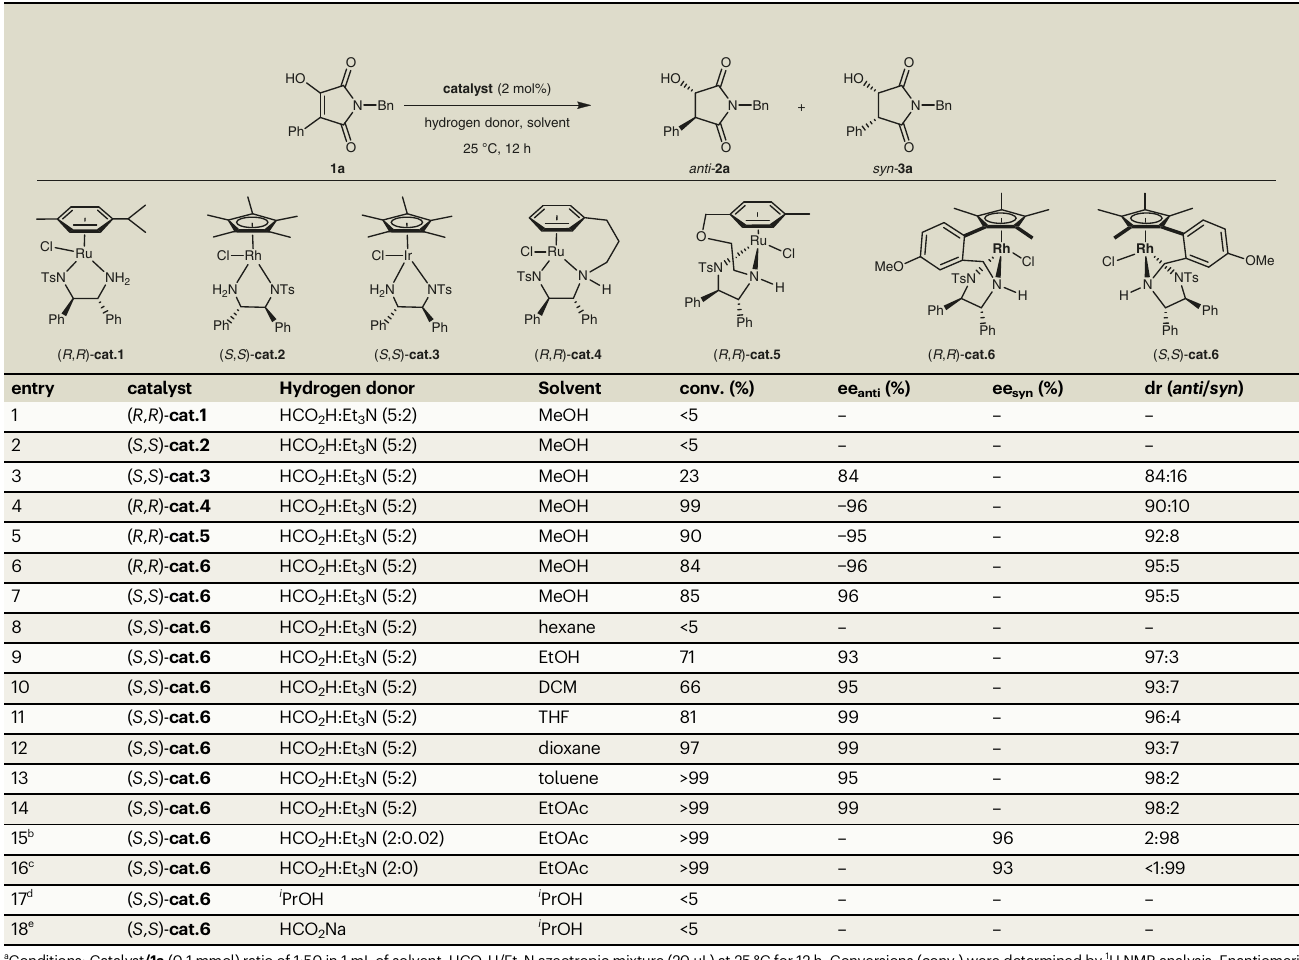
Table 1 | Optimization for Rh(III)-catalyzed DKR-ATH of 1a a